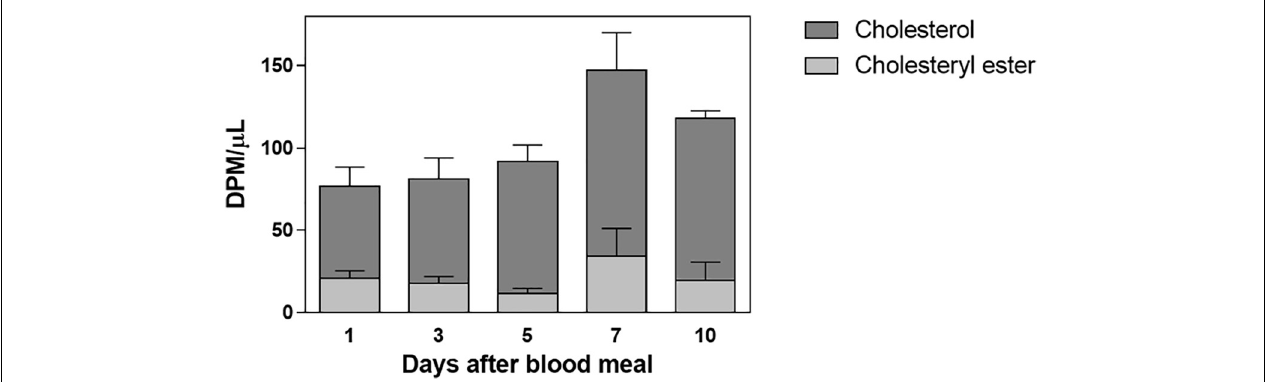
FIGURE 2 | Labeled cholesterol is found in the hemolymph after a blood meal. Rhodnius prolixus adult females were fed on 3 H-cholesterol-enriched blood, and on different days after the blood meal hemolymph was collected. Total lipids were extracted from the hemolymph and were analyzed by HPTLC. The radioactivity associated with free cholesterol (dark bars) and esterified cholesterol (light bars) was quantified and expressed as DPM/ µ l ± SEM for two to three determinations. p > 0.05 by one-way ANOVA. HPTLC, high-performance thin-layer chromatography; DPM, disintegrations per minute.